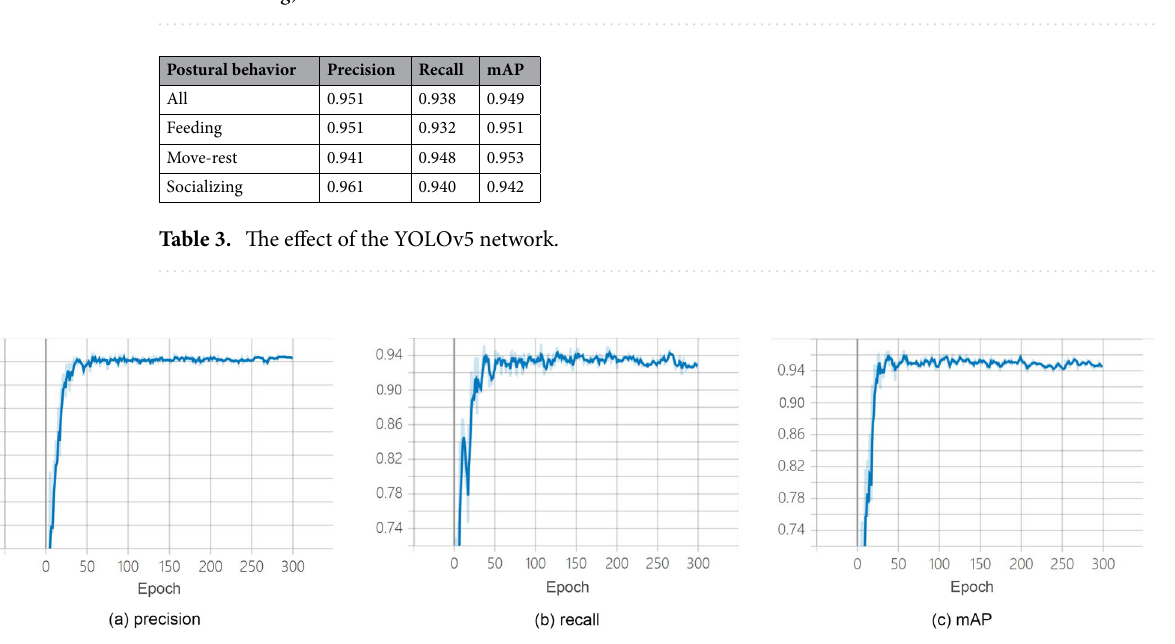
Figure 5. Semantic segmentation image of loris postural behavior (red indicate moving behavior and green indicate resting ).